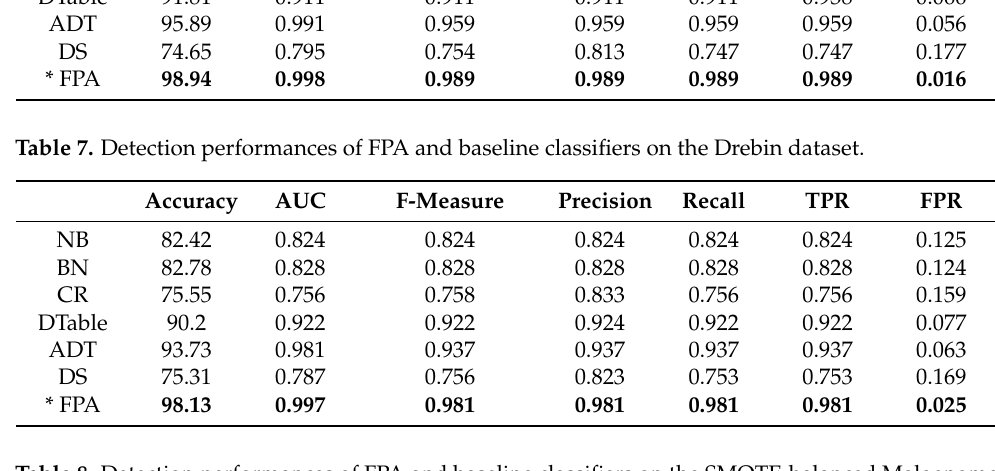
Table 8. Detection performances of FPA and baseline classifiers on the SMOTE-balanced Malgenome